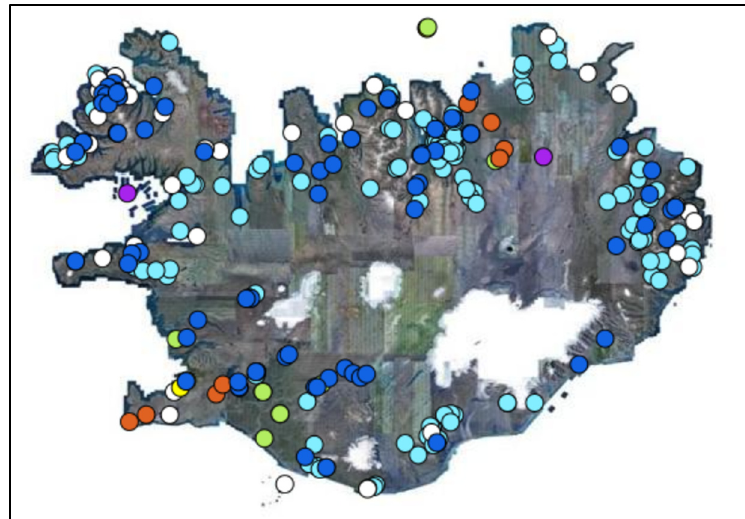
Figure 1. Map of power plants in Iceland. Orange dots represent geothermal power plants, dark blue dots represent hydroelectric power plants, bright green dots represent wind turbine power plants, yellow dots represent solar power plants, purple dots represent petroleum-based power plants, pale blue dots represent home power plants, white dots represent backup power plants. Map data obtained from Government of Iceland [72].